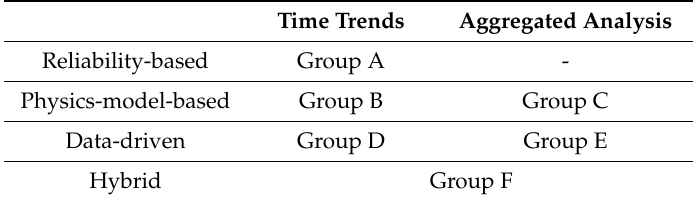
Table 1. Potential artificial intelligence (AI) approaches for HUMS